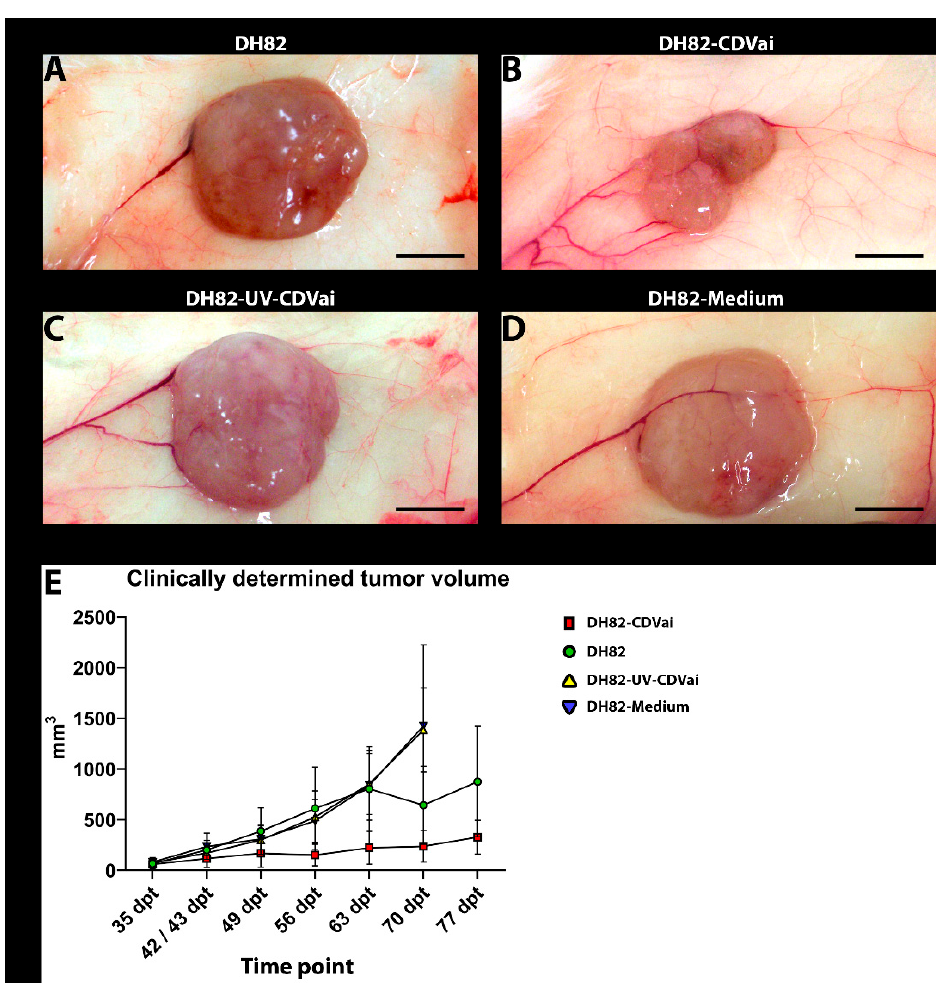
Figure 1. Representative gross pictures of xenografts at 63 dpt of ( A ) non-infected DH82 cells (DH82), ( B ) DH82 cells infected with canine distemper virus (CDV) (DH82-CDVai), ( C ) DH82 cells injected with UV-inactivated CDV (DH82-UV-CDVai) and ( D ) DH82 cells injected with medium (DH82-medium). DH82-CDVai neoplasms were significantly smaller than tumors of all control groups. (A-D) Scale Bar = 0.5 cm, ( E ) Graphical overview of tumor growth (mm 3 ) over time (days post-transplantation, dpt). Interestingly, the volume of DH82-CDVai xenografts remains relatively stable, while controls showed a continuous progression.